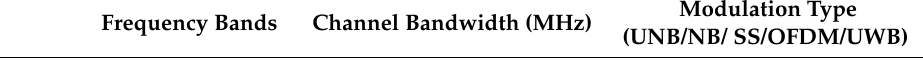
Table 2. Summary of key physical layer parameters for several IoT